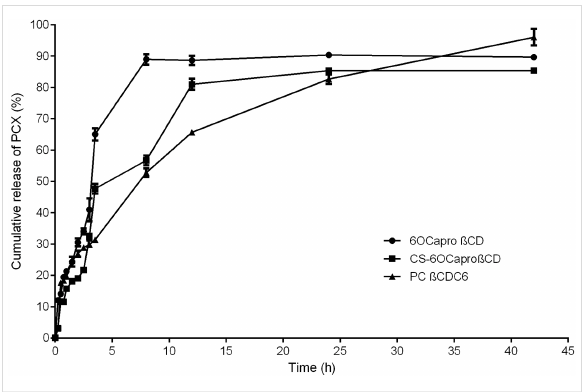
Figure 5: Cumulative release profile of PCX from different amphiphilic CD nanoparticles at pH 7.4 phosphate buffer solution under sink condi- tions ( n = 3, ±